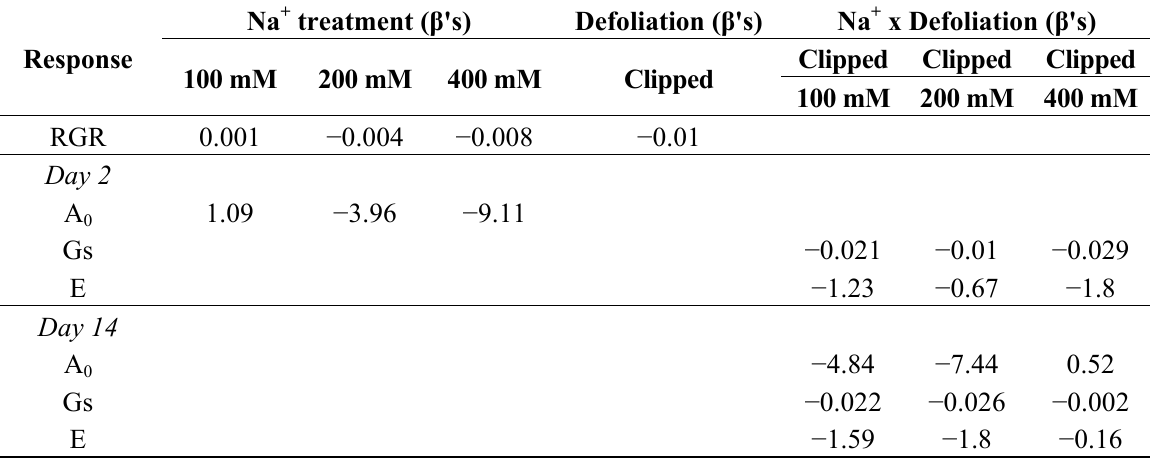
Table 1. Regression coefficients ( β ) for linear mixed model results from five Sporobolus species treated with Na (four levels including 0 mM) and clipped in a full factorial experiment. The table shows the parameter estimates for all treatment levels for significant predictors (see Table A1). RGR = relative growth rate; A G = stomatal conductance; and E = s